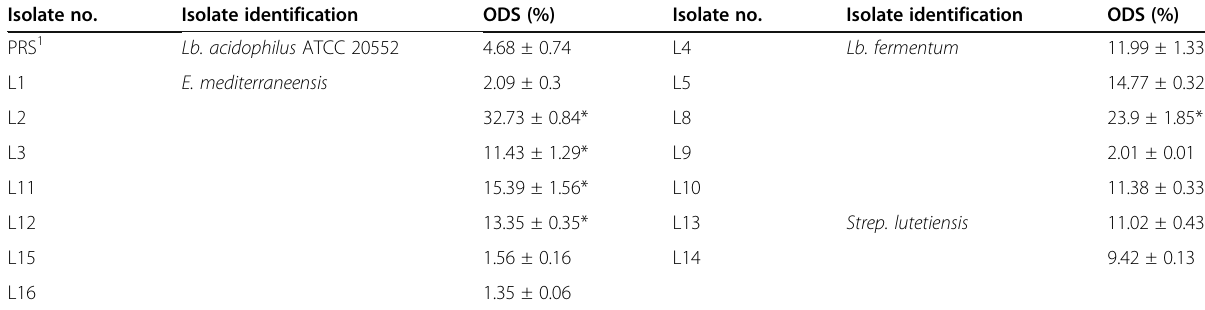
Table 5 Overall digestion survival (ODS) of potential probiotic LAB Isolate no.